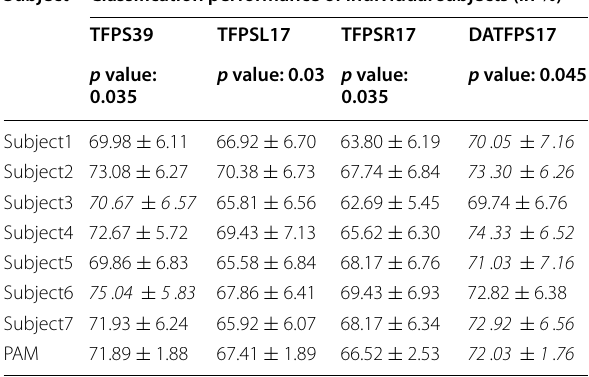
Table 3 Average classification accuracy ( deviation) of common feature